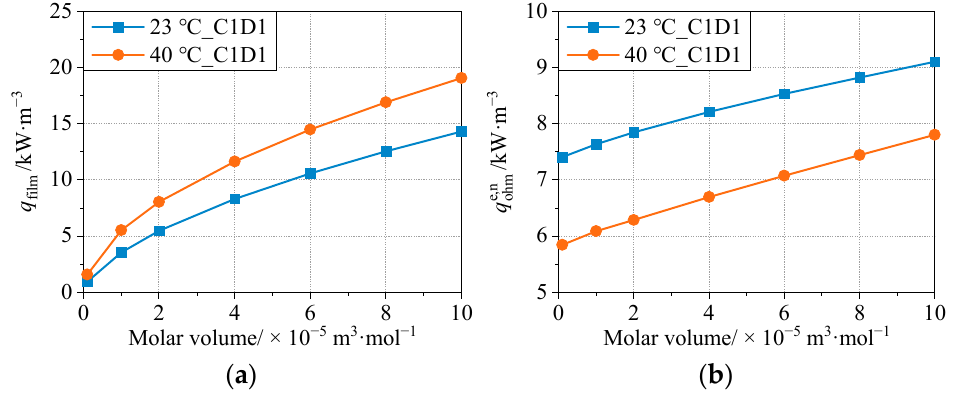
Figure 16. Simulation results of SEI and negative electrolyte ohmic heat generation rates during the discharge process of cells after aging when using different SEI film molar volumes. ( a ) SEI growth heat and ( b ) negative electrolyte ohmic heat.